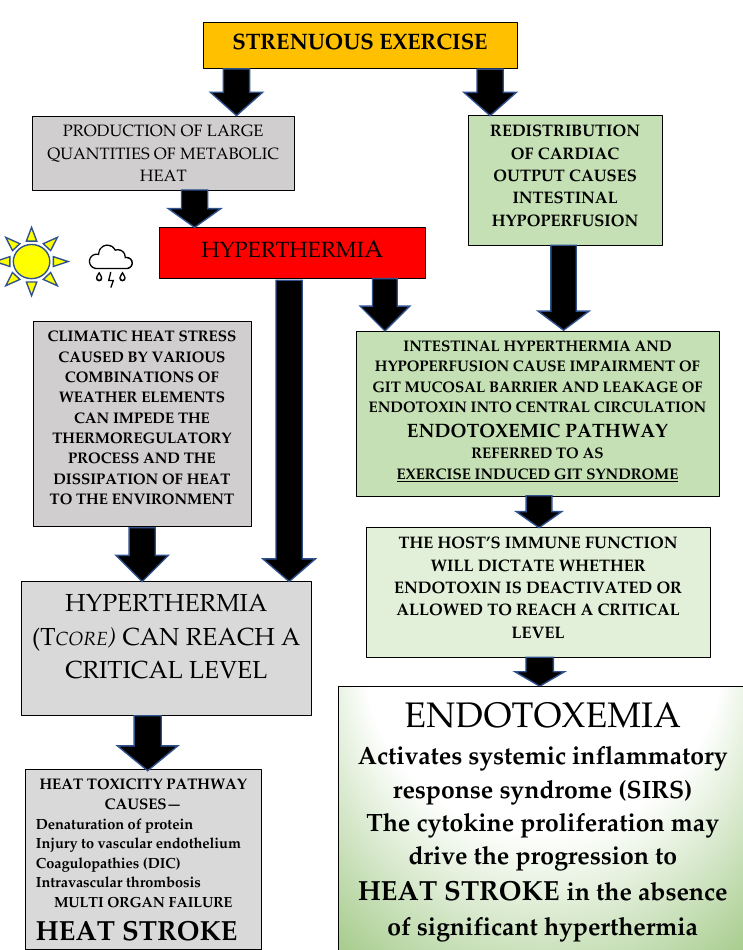
Figure 7. There are two proposed pathophysiological pathways for EHI. The strenuous exercise of racing produces a large amount of metabolic heat, most of which is stored, resulting in hyperther- mia. If an individual’s ability to thermoregulate is impaired by high levels of heat and humidity, hyperthermia may reach critical levels. This can trigger the heat toxicity pathway, potentially leading to heat stroke with multi-organ failure. Strenuous exercise also causes a redistribution of cardiac output. Heat and intestinal hypoperfusion combine to cause impairment of the intestinal mucosal barrier, allowing leakage of endotoxin into the central circulation. Limitation of this endotoxemic or ‘heat sepsis’ pathway is dependent on the host’s immune system, which if functioning normally can deactivate endotoxin. If this does not occur, endotoxin can reach a critical level and may activate the systemic inflammatory response syndrome (SIRS), stimulating the production of cytokines, which might actually drive the condition and are thought to mediate many of the adverse consequences of the EHI/HS